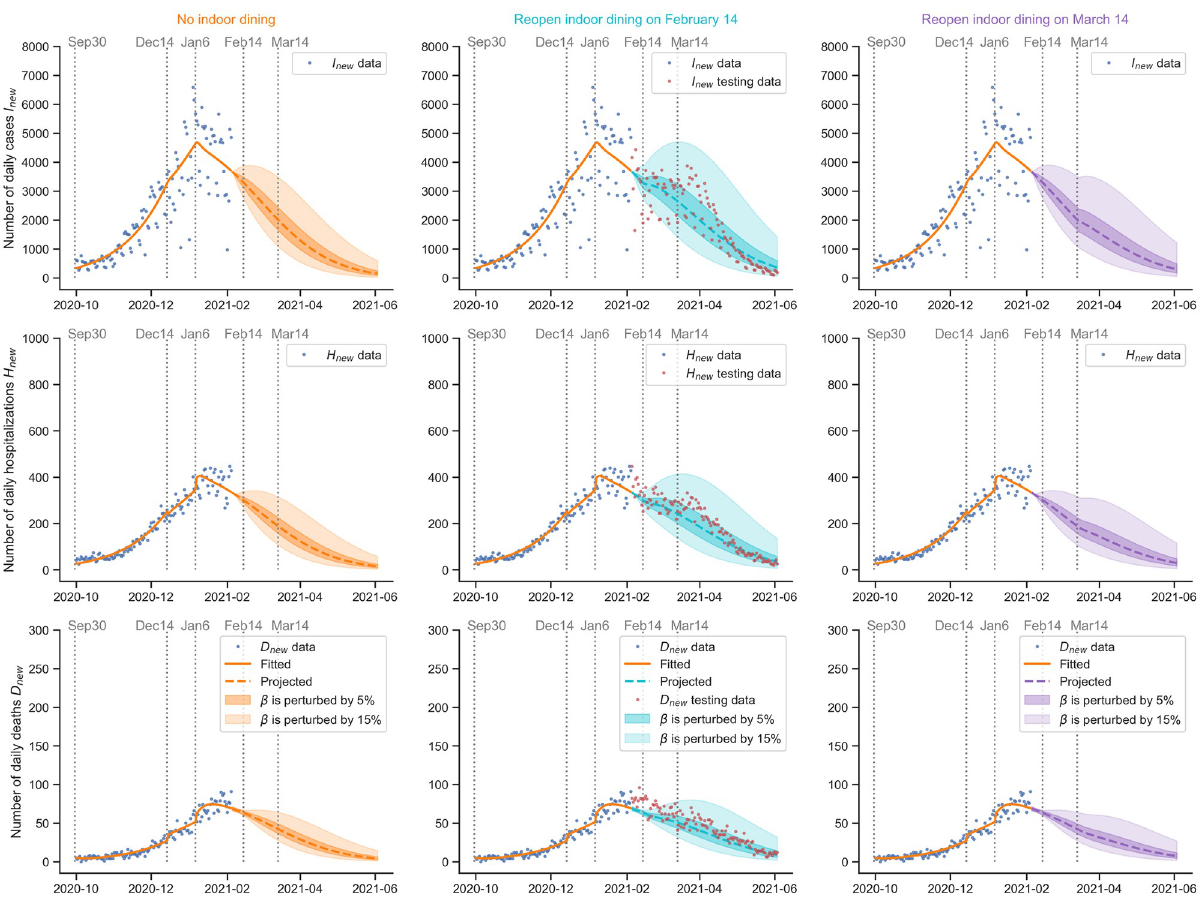
Fig 10. Projection of daily cases, hospitalizations, and deaths in New York City with uncertainties and scenarios. Reopening scenarios on February 14 and March 14 are considered. An increase in infectious, hospitalized, and deceased population is expected if the restaurants are reopened in the same way as Stage 5 (September 30, 2020 to December 14, 2020). Postponing the reopening of restaurants from February 14 to March 14 may reduce the number of infectious, hospitalized, and deceased individuals. The actual situation might vary depending on the details and implementations of the actual indoor dining policies that take place in 2021. Remarks : The projections were made and the paper was submitted in February. When updating the paper in June, we overlaid the new data of daily cases, hospitalizations, and deaths from February to June as the testing data. Indoor dining was actually reopened on February